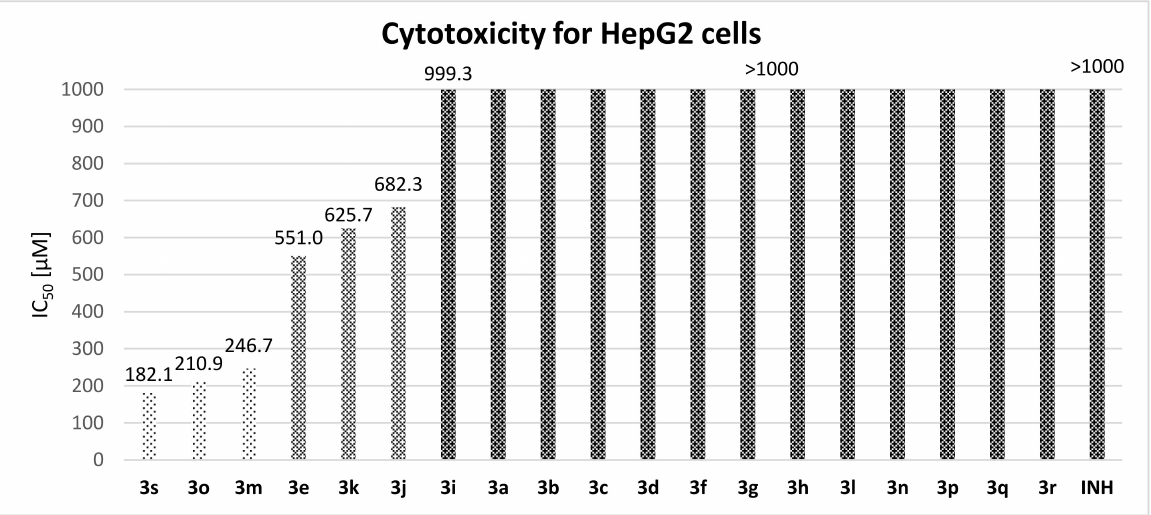
Figure 3. IC 50 values for HepG2